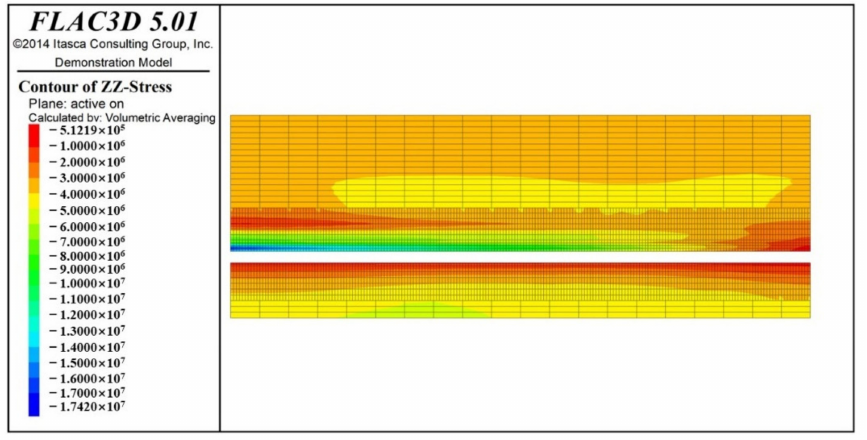
Figure 8. Vertical stress cloud map of the gob-side roadway.